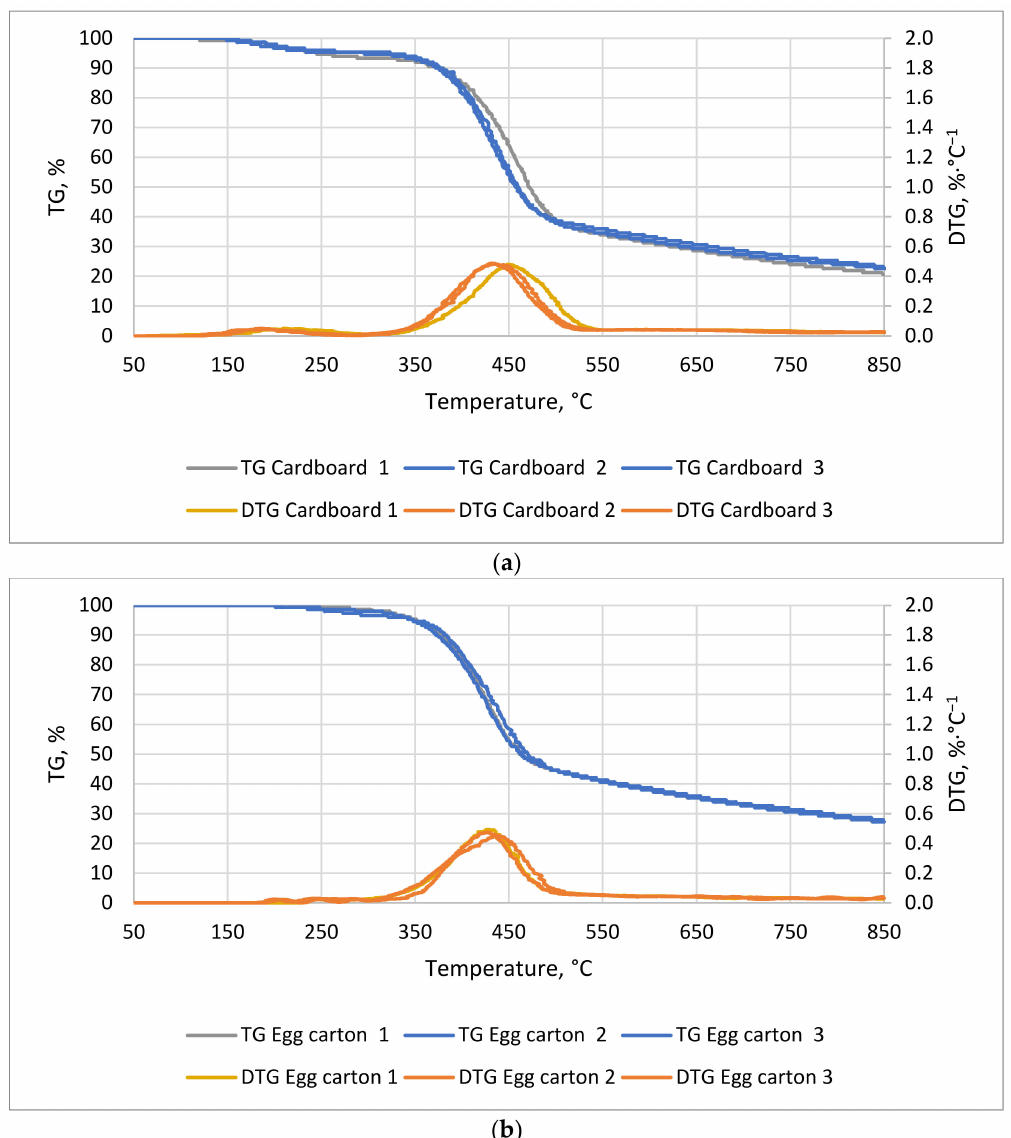
Figure 3. Characteristics of the TG/DTG of cardboard waste: ( a ) cardboard; ( b ) egg cardboard. Four transformations occurred in the thermal analysis of cardboard. The first three transformations were exothermic, and led to the release of heat of 12.1, 357.0, and 10.4 J × g − 1 , respectively (Table 4). The final transformation was endothermic: − 188.8 J × g − 1 . The en- ergy balance of the transformation of the cardboard was positive (190.8 J × g − 1 ). In the case of egg cardboard, three transformations occurred. The first and second transformations were exothermic: 67.0 J × g − 1 and 159.5 J × g − 1 , respectively. The third, however, was endothermic ( − 132.4 J × g − 1 ). As a result, the energy balance of the thermal transforma- tions of egg cardboard was exothermic (94.0 J × g − 1 ). For both materials, DSC results show that the biggest exothermal reactions took place at 220–340 ◦ C, and endothermal reactions occurred above 420 ◦ C (Figure 2). This suggests that temperatures above 420 ◦ C should be avoided and process temperatures should be maintained in the range of 220–340 ◦ C to reduce the energy needs for the pyrolysis process of cardboard